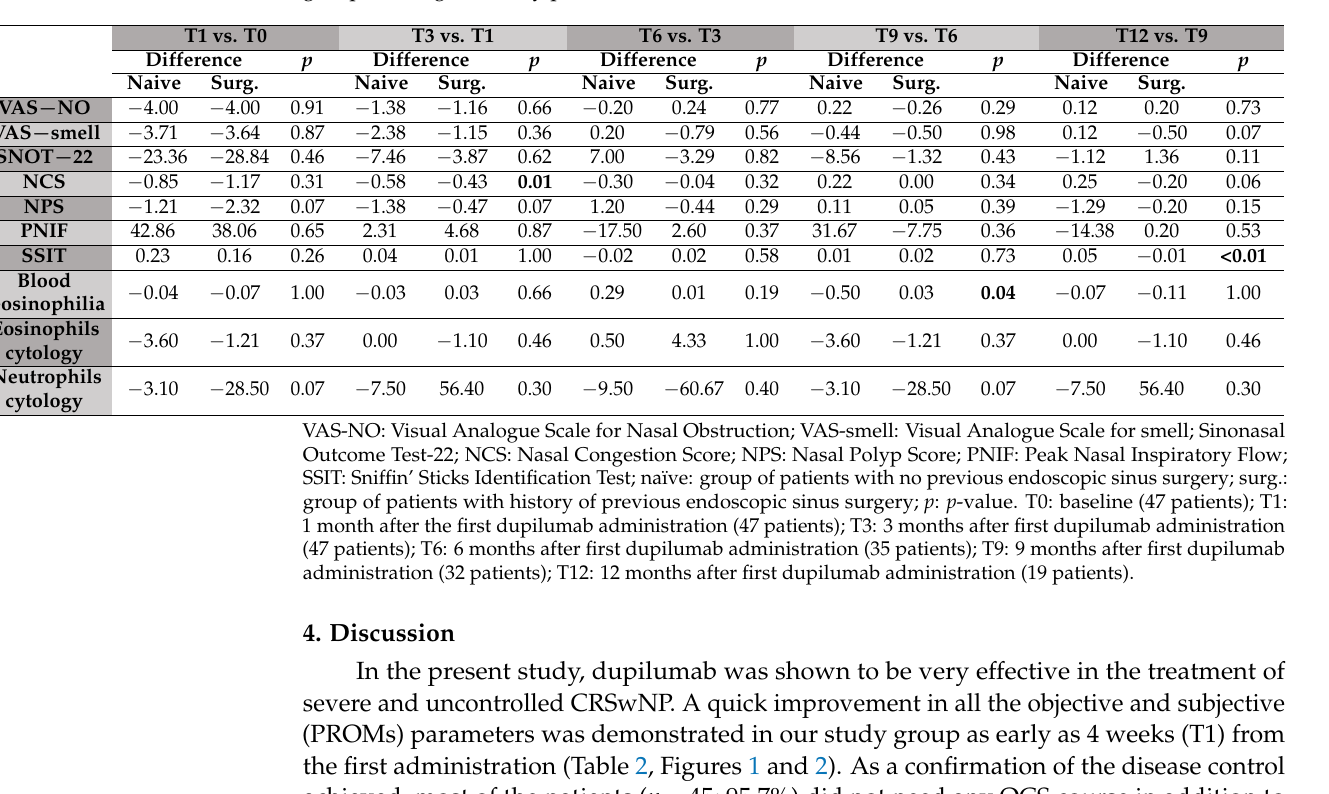
Table 4. Objective measurements’ and symptoms’ comparison between naïve and post-surgical groups during the study